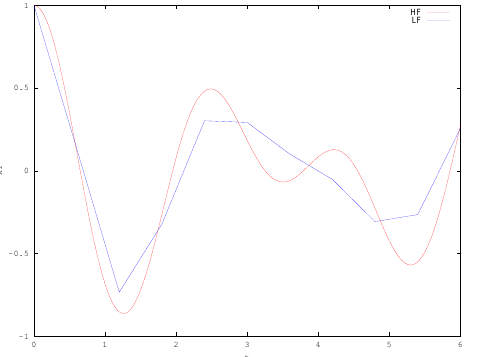
t 6 using ∆ t = 0.01 labeled ≤ ≤ k 1 = k 3 , k 2 4 ≤ ≤